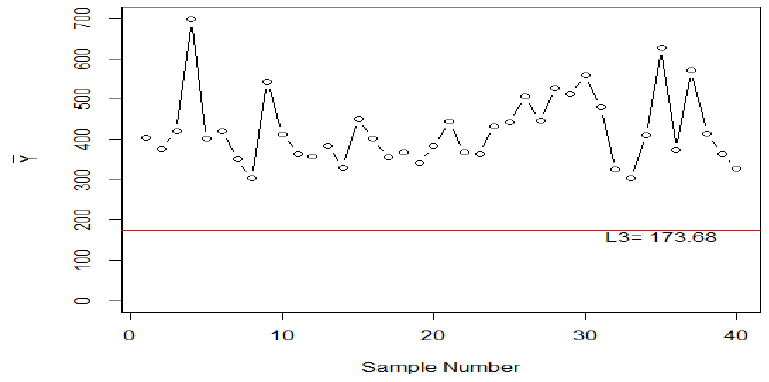
Figure 3. Proposed chart for the carbon fibers data.